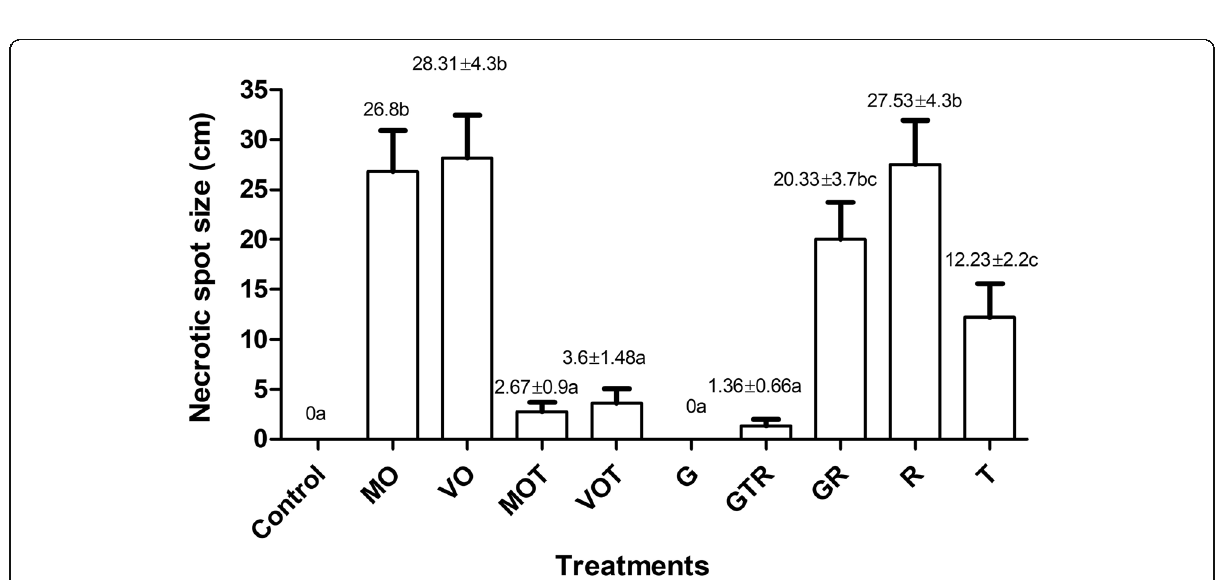
Fig. 4 Necrotic spot size produced by Rhizoctonia solani in corn seedlings. MO, mineral oil without Trichoderma asperellum or R. solani ; VO, vegetable oil without T. asperellum or R. solani ; MOT, mineral oil with T. asperellum ; VOT, vegetable oil with T. asperellum ; G, granular formulation without T. asperellum or R. solani ; GTR, granular formulation with T. asperellum ; GR, granular formulation without T. asperellum ; R, R. solani without treatment; T, T. asperellum without formulation. Letters indicate statistical